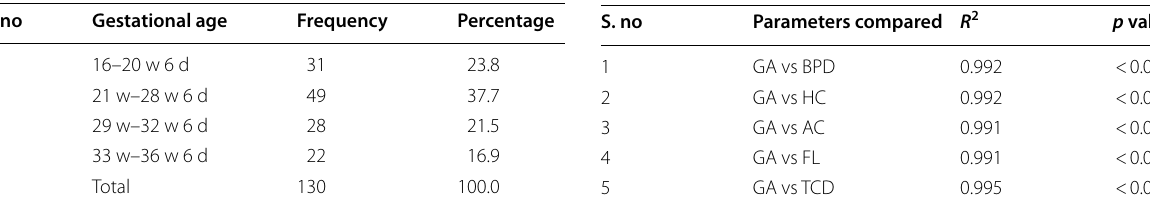
Table 2 Correlation of BPD, HC, AC, FL and TCD with GA using regression